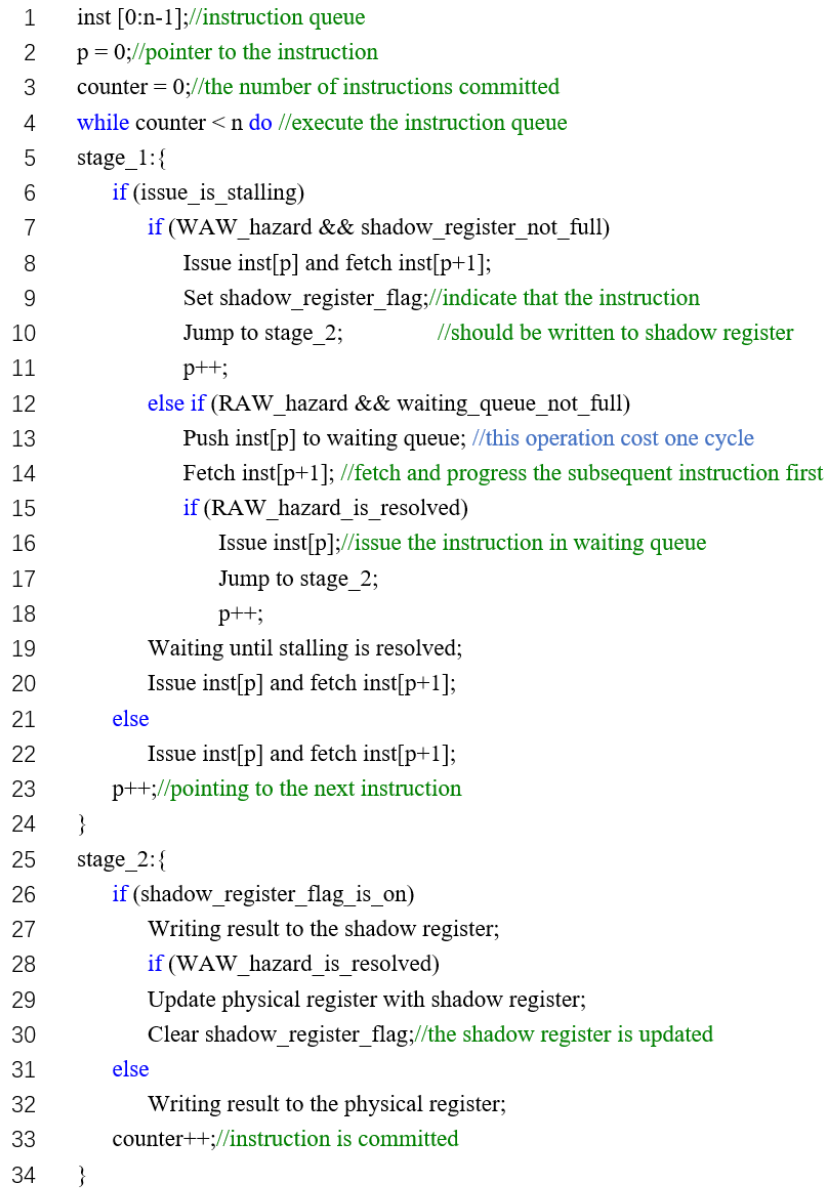
Figure 7. Pseudocode of the operation of pipeline.